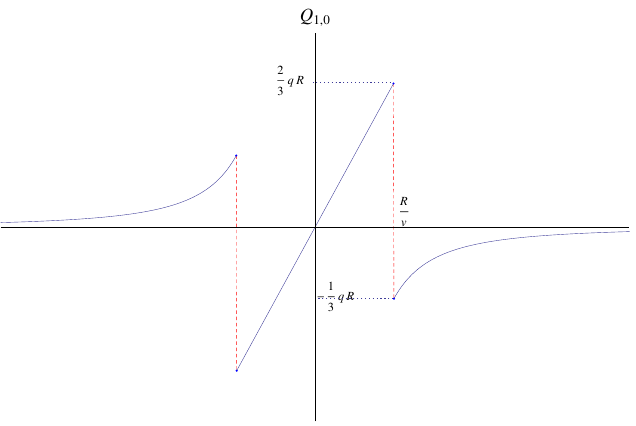
Figure 1 . The dipole charge within a sphere of radius R , produced by a charged particle moving with constant velocity along the z direction. The discontinuities occur when the particle enters and exits the integration